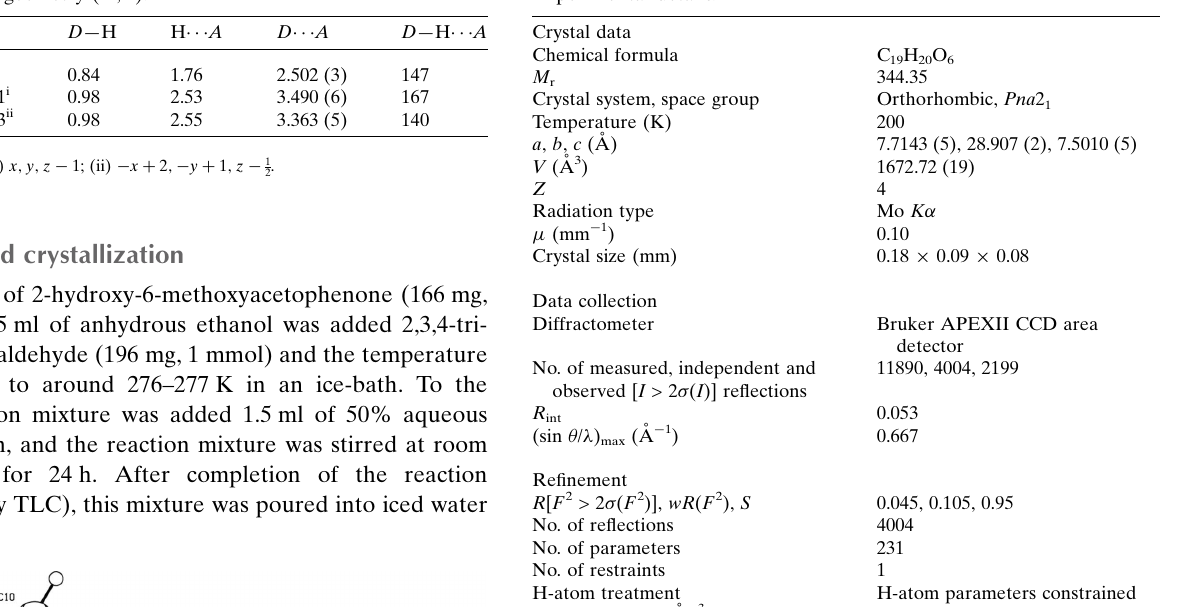
Table 1 Hydrogen-bond geometry (A˚ , (cid:2) ).